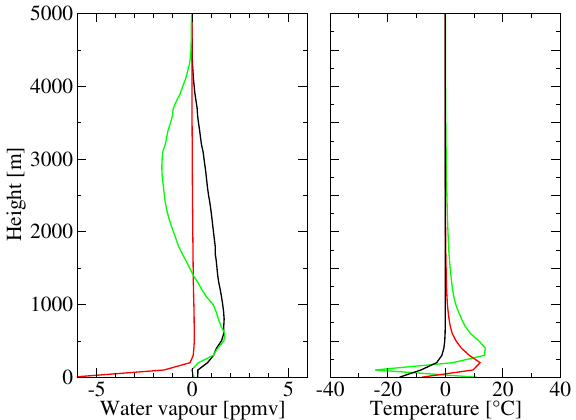
Figure 5. Back-transformed singular vectors of e K of water vapour and temperature for the first three singular values calculated by us- ing the winter